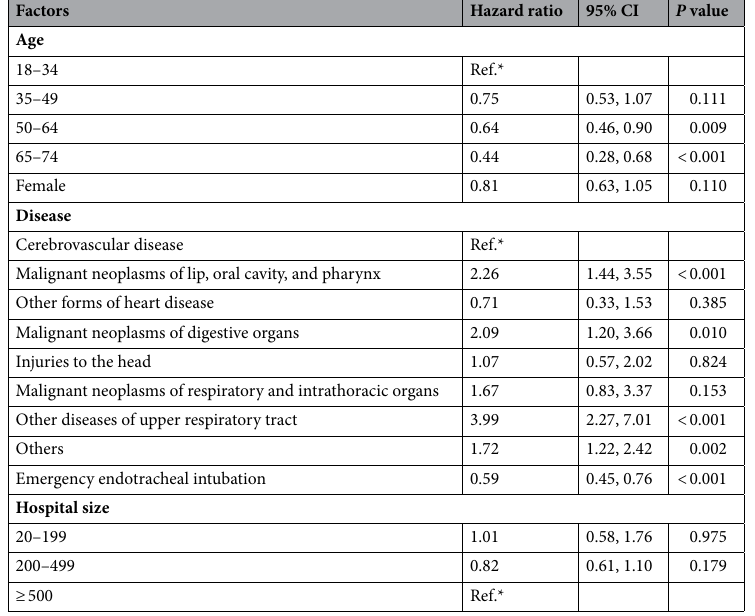
Table 2. Cox proportional hazards analysis for tracheostomy decannulation.